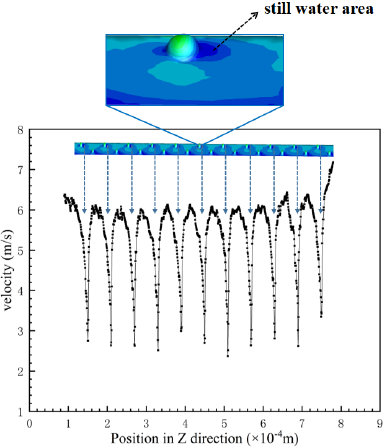
Figure 6. The flow through the positive crowns can form a still water area. In this area the inten- sity of turbulent kinetic energy is low.